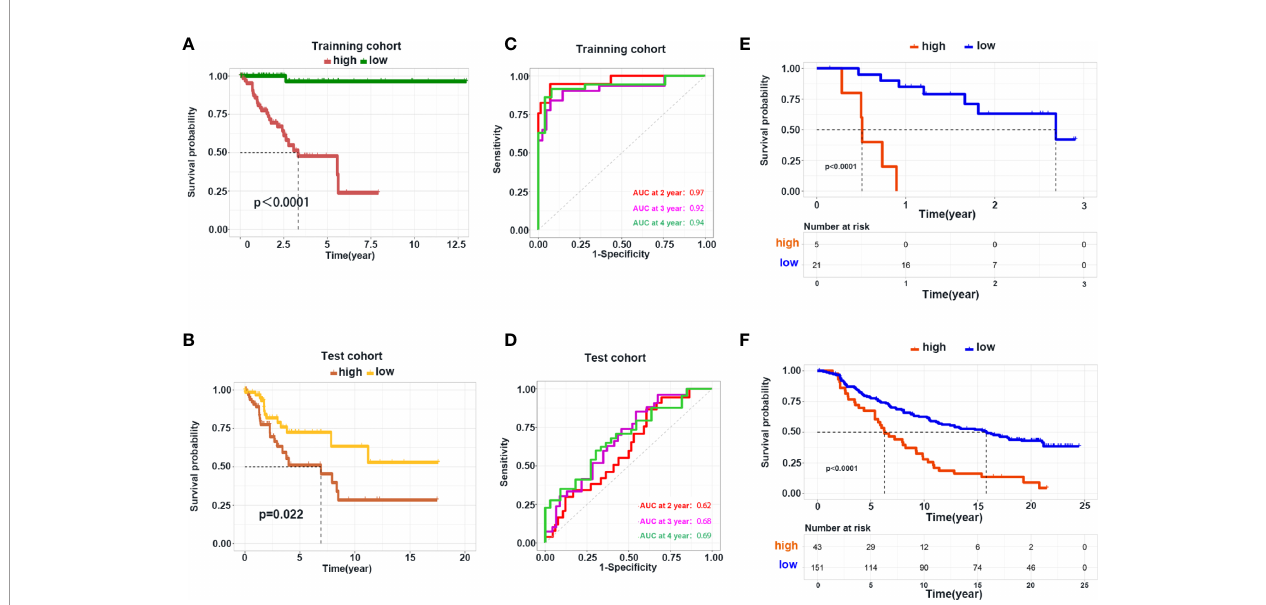
FIGURE 7 | Construction and validation of the prediction model. (A, B) Kaplan – Meier curve shows the OS in the high- and low-risk group in the training and test cohorts. (C, D) ROC curve analysis shows the AUC of the prediction model in the training and test cohorts. (E, F) Validation of the prediction model using the dataset of patients with metastatic melanoma and urothelial cancer receiving immunotherapy